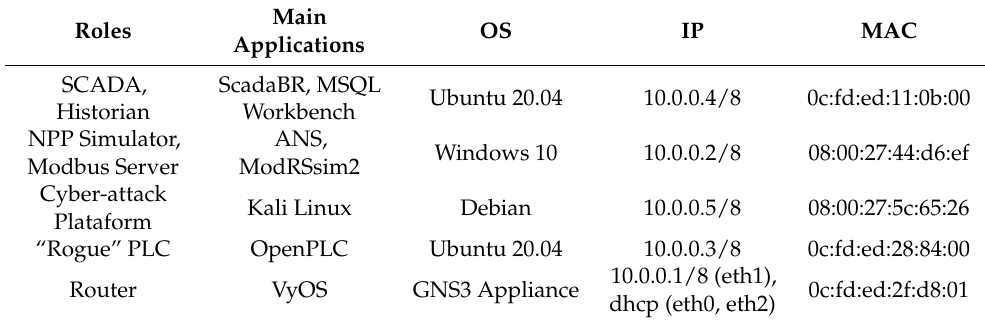
Figure 8. GNS3 nuclear testbed topology. Table 4. Nuclear testbed IP